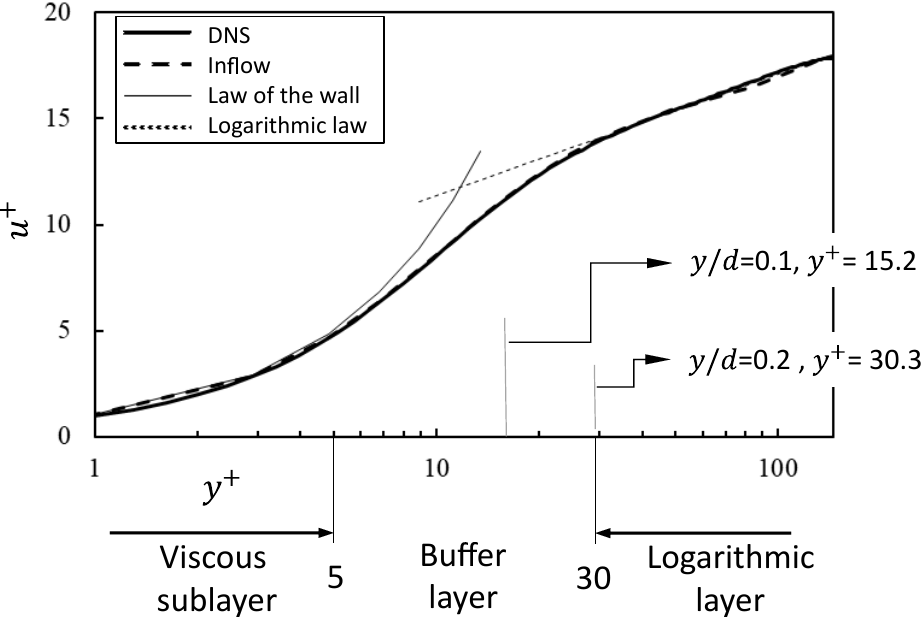
Figure 8. Mean streamwise velocity profiles. y / d = 0.1,0.2 denote y + = 15.2,30.3,